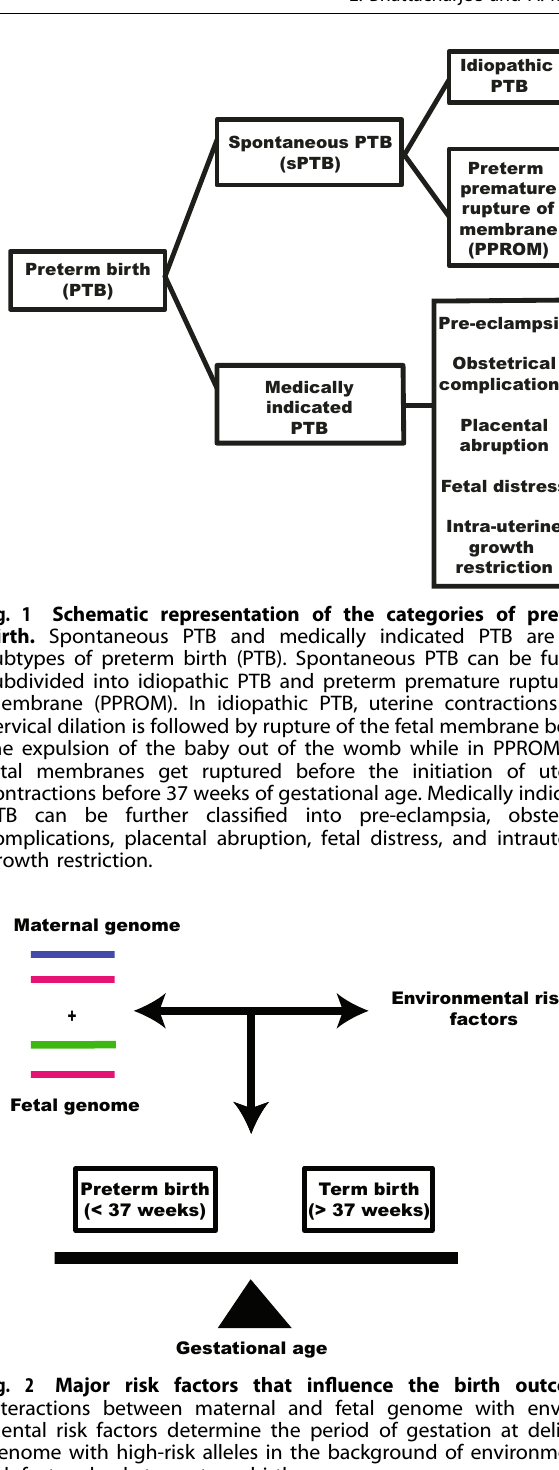
EBF1 . Early B-cell factor 1 encoded by EBF1 , is essential for normal B-cell development 31 . Low EBF1 mRNA in the second and/or third